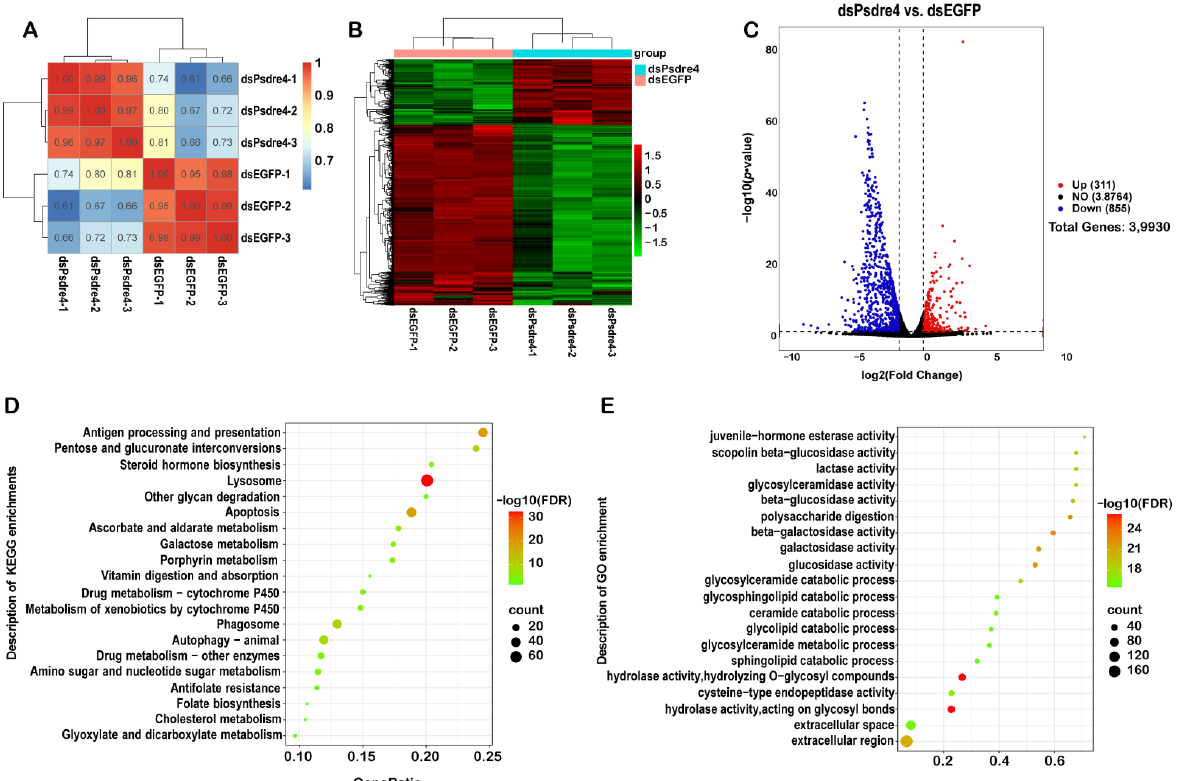
Figure 5. The transcriptomes of P. striolata injected with 100ng dsEGFP or 100ng dsPsdre4 were analyzed by RNA-sequencing analysis. ( A ). Pearson’s correlation computation of transcriptome data in all samples. Colors indicate the coefficient values between classes. ( B ). Hierarchical clustering analysis of the transcriptomic data. High-expression genes are shown in red and low-expression genes are shown in green. There were significant differences in the transcriptional levels between dsEGFP-injected groups and dsPsdre4-injected groups. ( C ). The volcano map of transcriptome sequencing results. The abscissa is log 2 FoldChange, and the ordinate is -log 10 ( p -value). The two vertical dashed lines in the figure are the two-fold differential expression threshold. The dotted line indicates the threshold of p -value = 0.05. Red dots indicate upregulated genes in this group, blue dots indicate downregulated genes, and gray dots indicate non-significantly differentially expressed genes. ( D ). Enrichment results of the KEGG pathway analysis with the highest score and lowest p -value for the enrichment score. ( E ). Bubble diagram of GO enrichment result. Twenty enriched terms of GO BP, CC, and MF are presented. In KEGG enrichment results and GO enrichment results, the size of the dot represents the proportion of genes, which is positively associated with the proportion of corresponding enrichment items. The change in color from red to green represents a change in p -value from low to high.